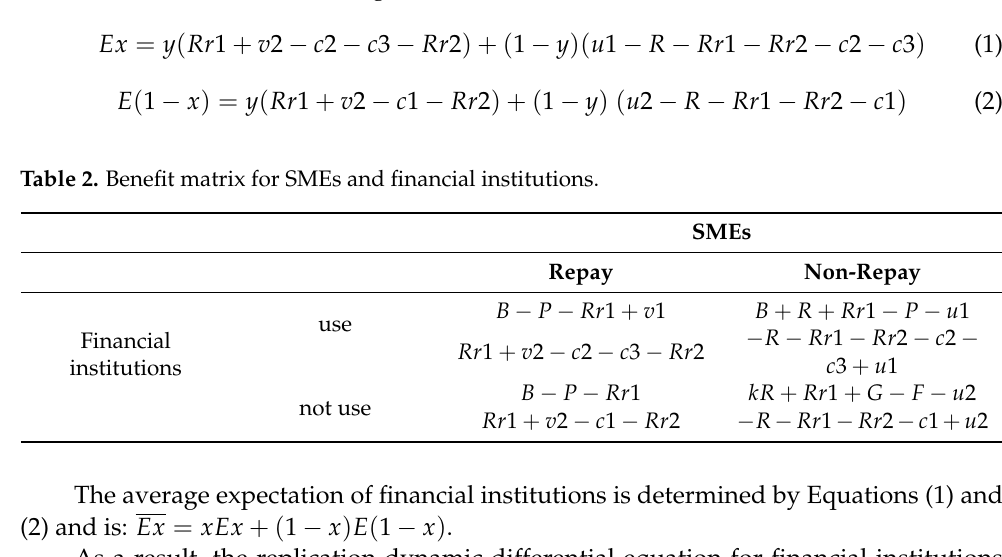
Repay Non-Repay